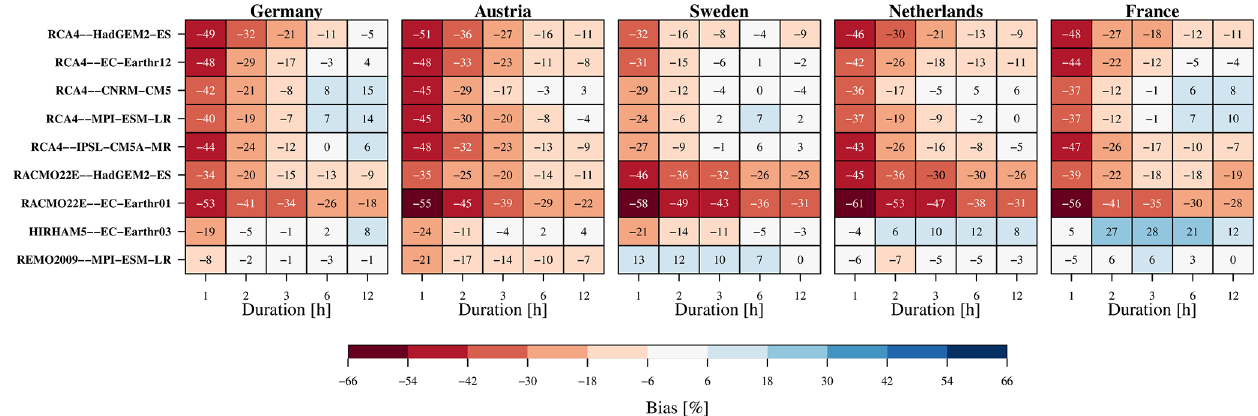
Figure 1. Evaluation of model ensemble for selected regions and for the 10-year depths. Gauge-based observations have been adjusted for spatial resolution and time sampling to approximate the statistics of the model resolution and sampling, as explained in the main text. Both colours and numbers indicate the bias.